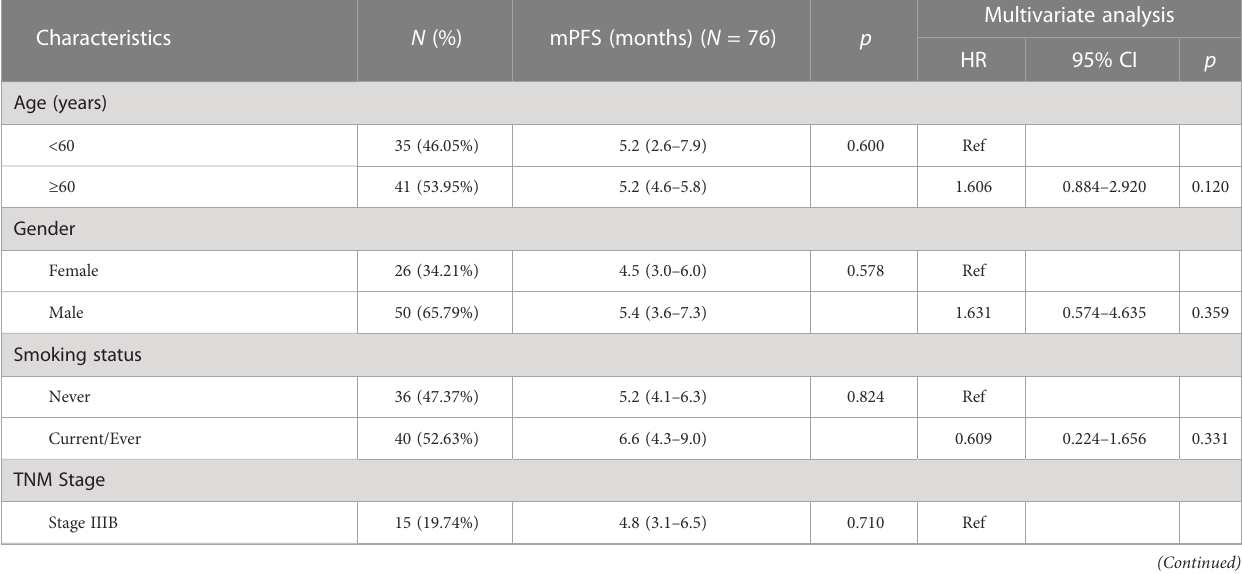
Characteristics